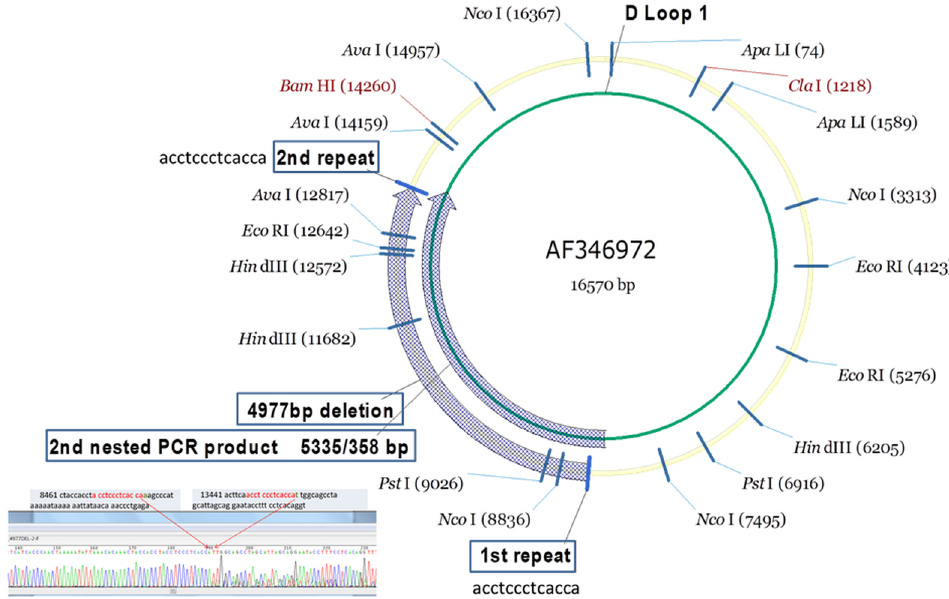
Fig 1. Detection of mtDNA 4977 and quantification of total and deleted mtDNA in leukocytes using real-time quantitative PCR.